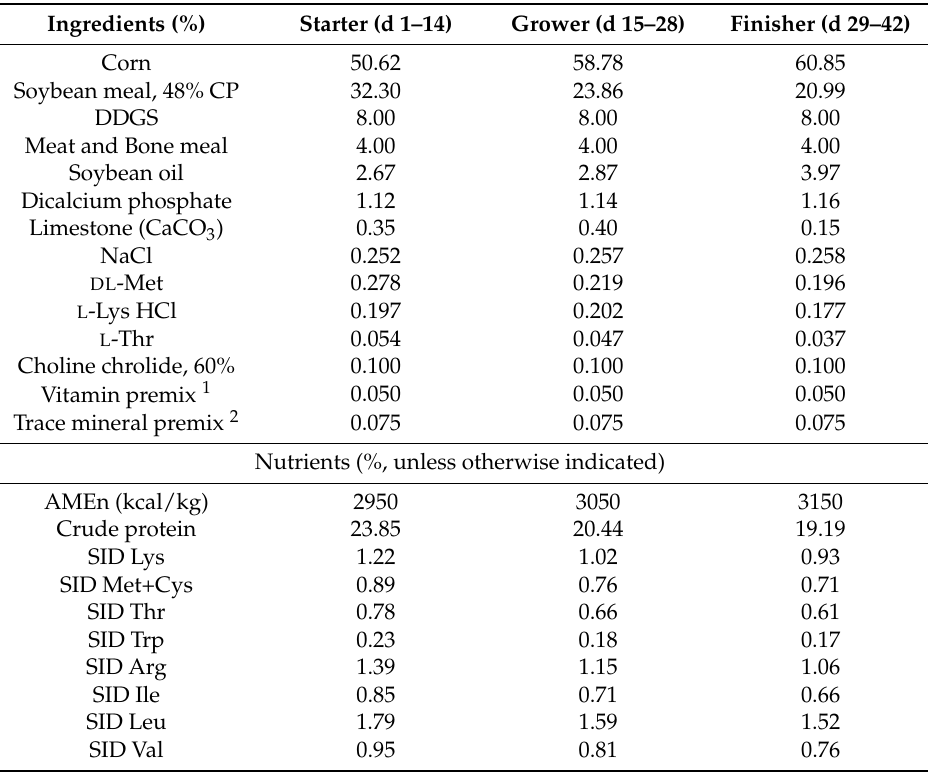
Table 1. Experimental diets composition (as fed